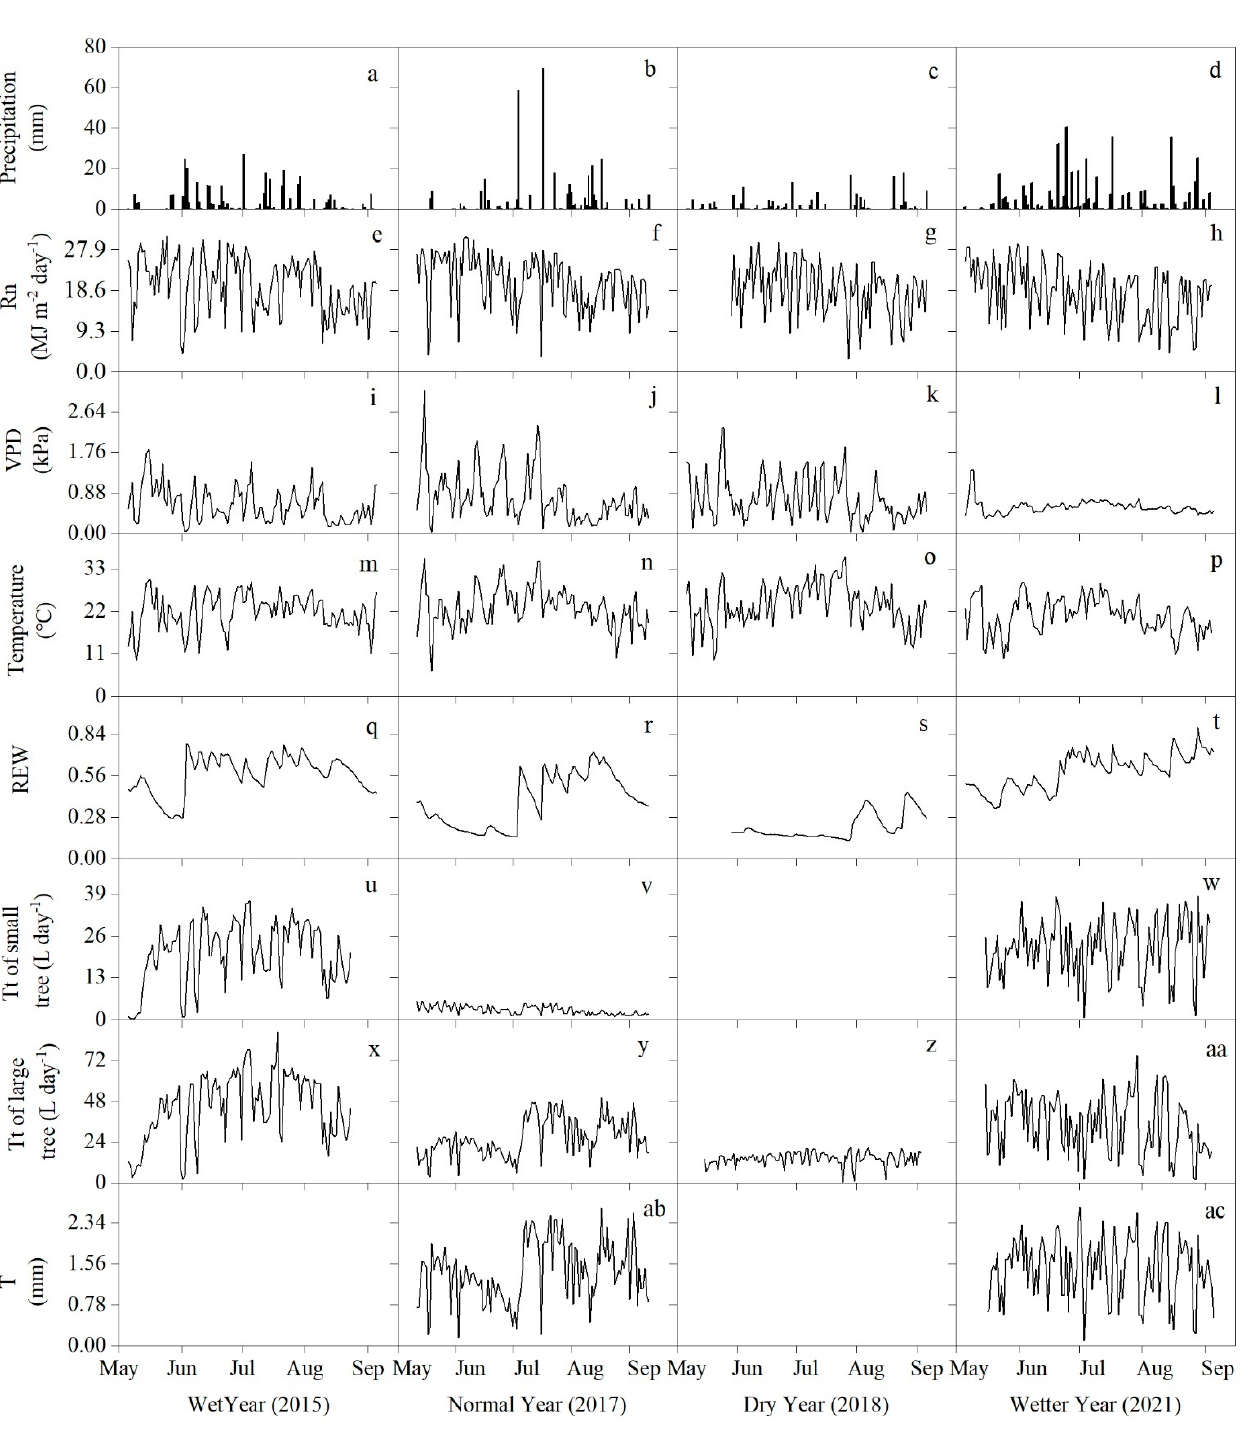
Figure 2. The daily variation in weather parameters (precipitation ( a – d ), solar radiation (Rn) ( e – h ), vapor pressure deficit (VPD) ( i – l ), and air temperature ( m – p ), relative extractable water (REW) of the 0 to 80 cm soil layer ( q – t ), and T t of small trees ( u – w ), T t of large trees ( x – aa ), and T ( ab , ac ) in the Betula platyphylla Sukaczev plot from May to September of the ‘wet’ year, ‘normal’ year, ‘dry’ year, and ‘wetter’ year. No available data of T t for small trees and no T data in the ‘wet’ year, and ‘dry’ year.